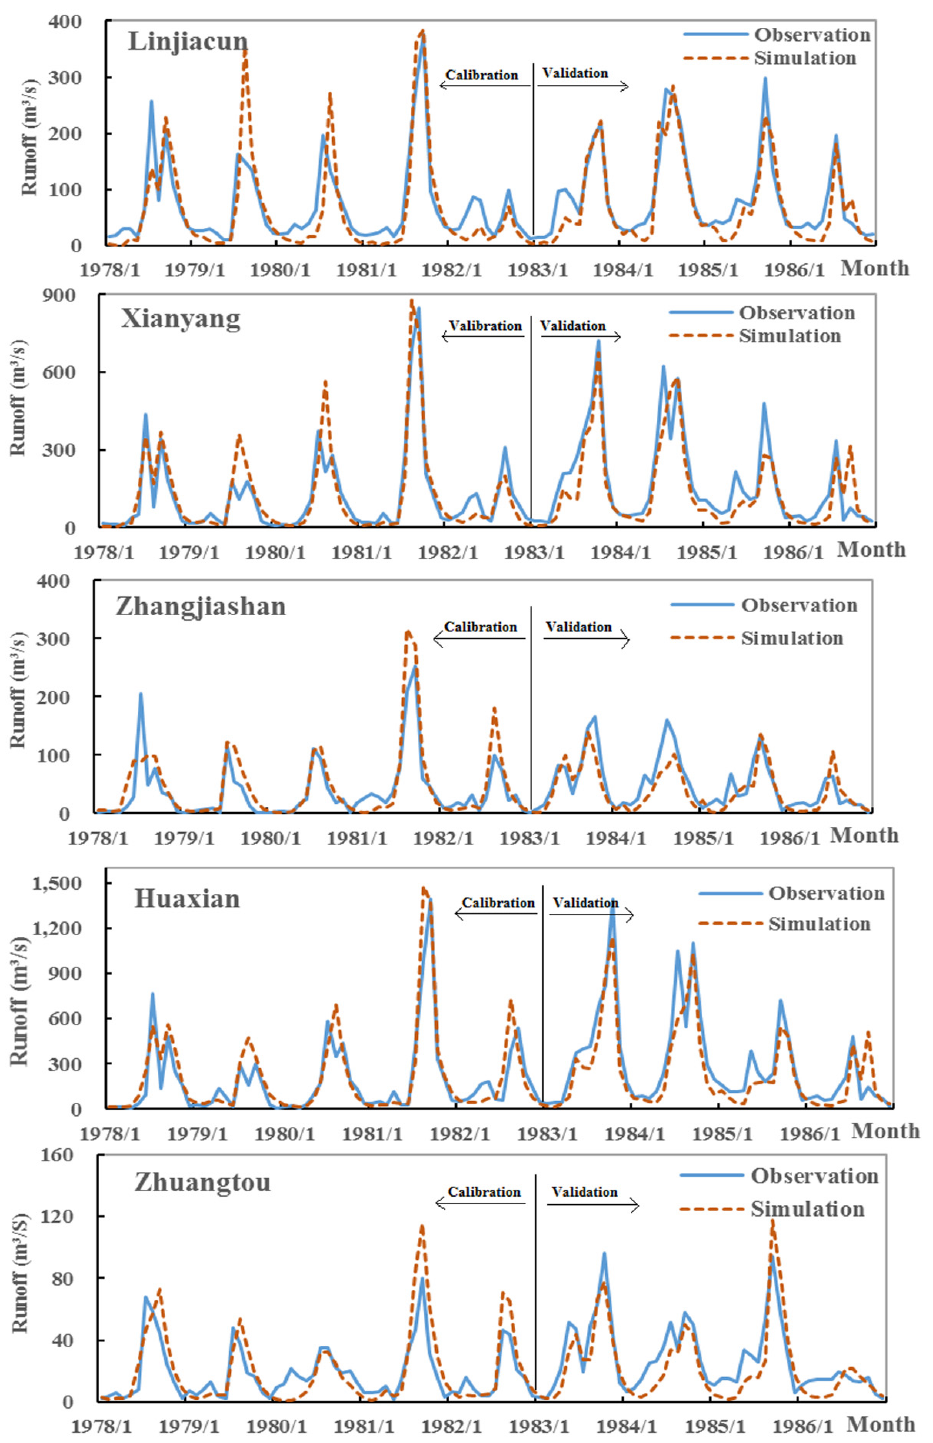
Figure 5. Observed versus simulated monthly flows during the calibration and validation periods.